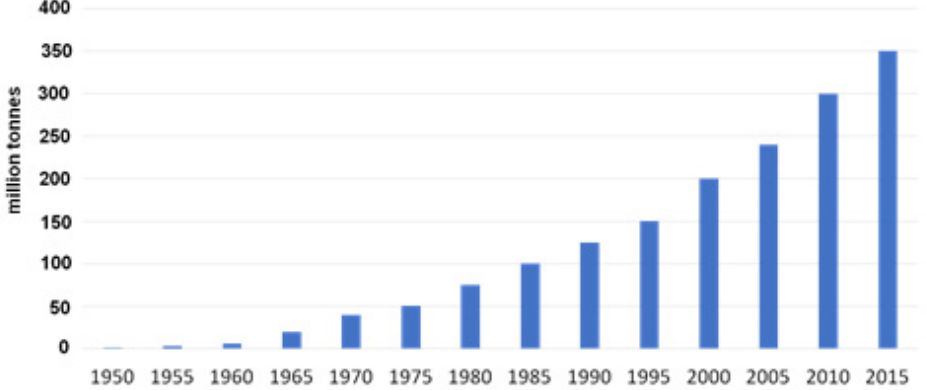
Figure 1. Evolution of global plastics production annually.